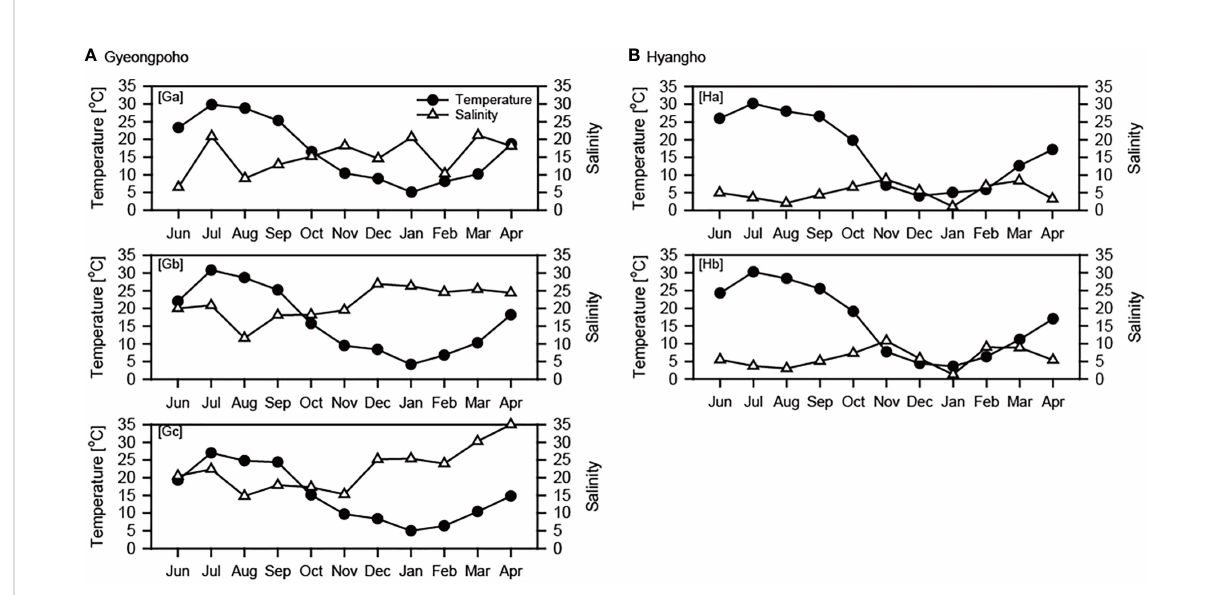
FIGURE 3 Monthly variations in water temperature and salinity at study sites in Gyeongpoho (A) and Hyangho (B) during sampling period.